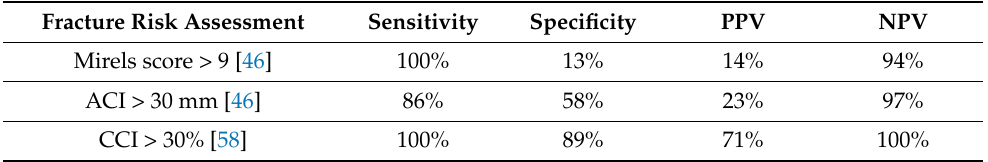
Table 2. Comparative intrinsic validity and diagnostic values of the Mirels score and axial cortical involvement (ACI), as described by the Dutch Bone Metastasis Study Group [46], and Circumferential Cortical Involvement (CCI) [58]. PPV: positive predictive value; NPV: negative predictive value. Fracture Risk Assessment Sensitivity Specificity PPV NPV Mirels score > 9 [46] 100% 13% 14% 94% ACI > 30 mm [46] 86% 58% 97% CCI > 30% [58]